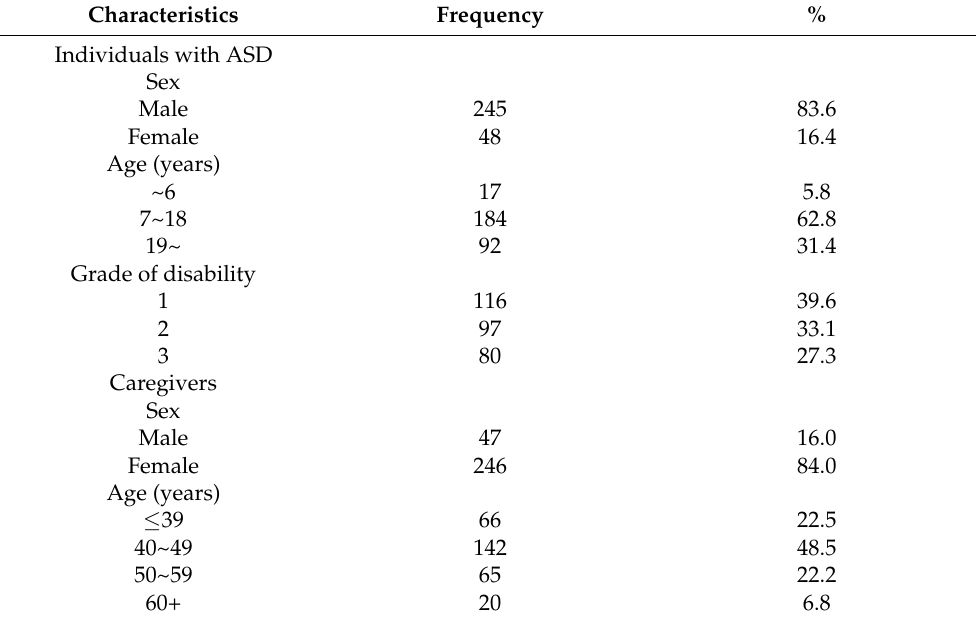
Table 1. Characteristics of individuals with ASD and their